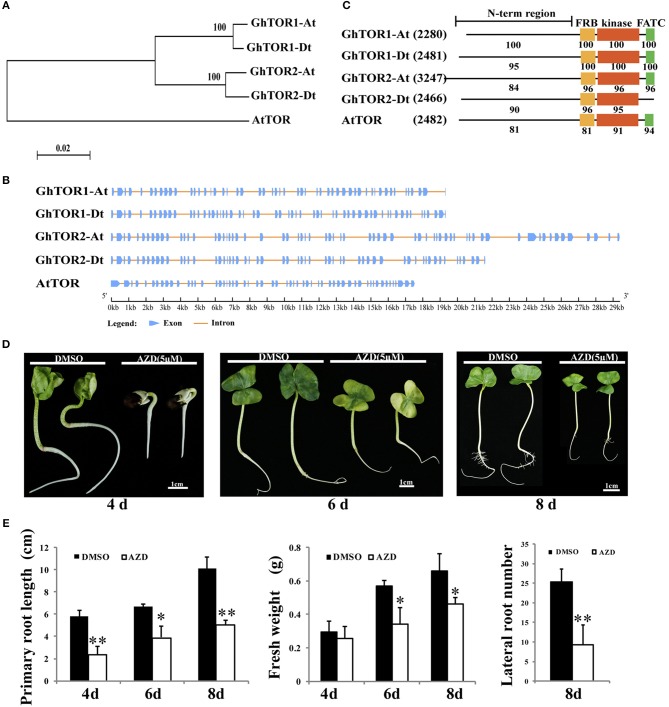
Phylogenetic analysis of GhTOR and pharmacological experiments. (A) Phylogenetic analysis of GhTORs and AtTOR using a neighbor-joining method. (B) Gene structure analysis of GhTOR genes. The number, position, and length of exons and introns within GhTOR genes are displayed. Boxes and lines indicate the exons and the introns, respectively. (C) Comparison of the conserved domains between GhTOR and AtTOR proteins. The number in brackets represents the amino acid number of every protein. Each value indicates the percentage of identity with the corresponding domain sequences of GhTOR1-At. (D) TOR inhibition by AZD significantly retarded cotton seedling growth. Sterile cotton seeds were germinated on plates with DMSO and AZD (5 μM) for different days. Cotton seedlings grown in MS medium containing DMSO and AZD (5 μM) for 4, 6, and 8 days were photographed, respectively. Bars = 1 cm. (E) The primary root lengths, fresh weights and lateral root numbers of (D) were measured. Each experiment contains three biological replicates. Error bars indicate ±SD for triplicates. Significant differences from the control are indicated by *P < 0.05, **P < 0.01.